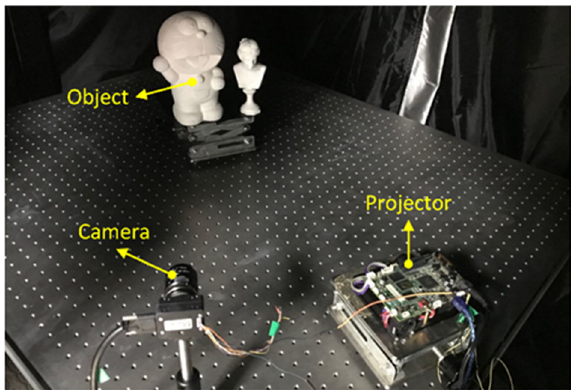
Figure 6. The experimental set-up.